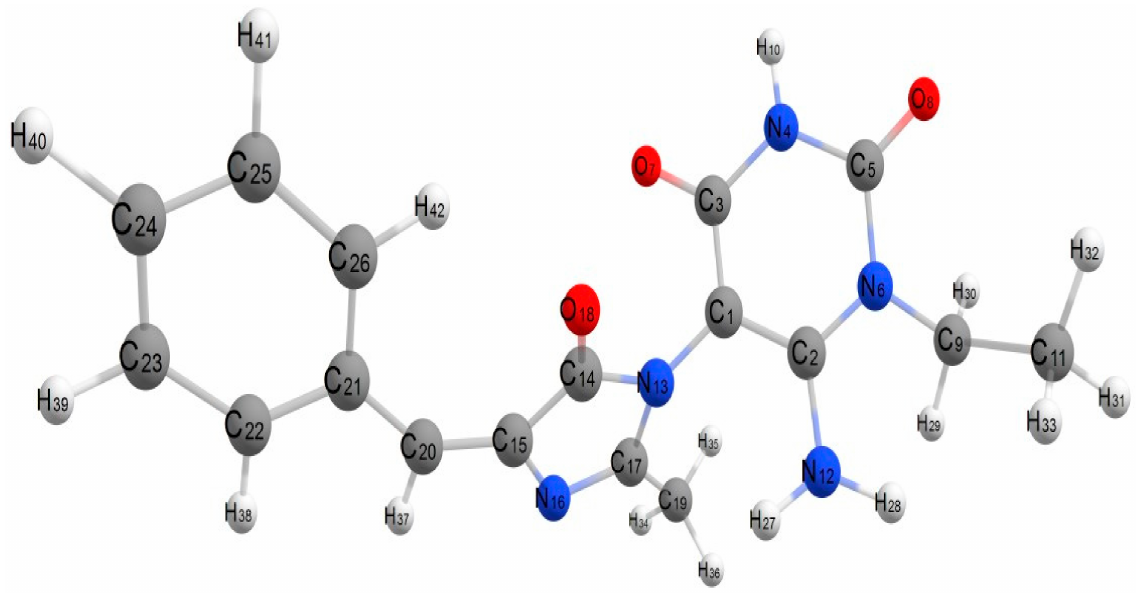
Figure 10. Optimized geometrical structure of compound ( 12 ), 6-amino-5-(4-benzylidene-2-methyl-5-oxo-4,5- dihydro-1 H - imidazol-1-yl)-1-ethylpyrimidine-2,4(1 H ,3 H )-dione by using DFT calculations. 6-Amino-5-(4-benzylidene-2-methyl-5-oxo-4,5-dihydro-1H-imidazol-1-yl)-1-methyl-2- thioxo-2,3-dihydropyrimidin-4(1H)-one, compound